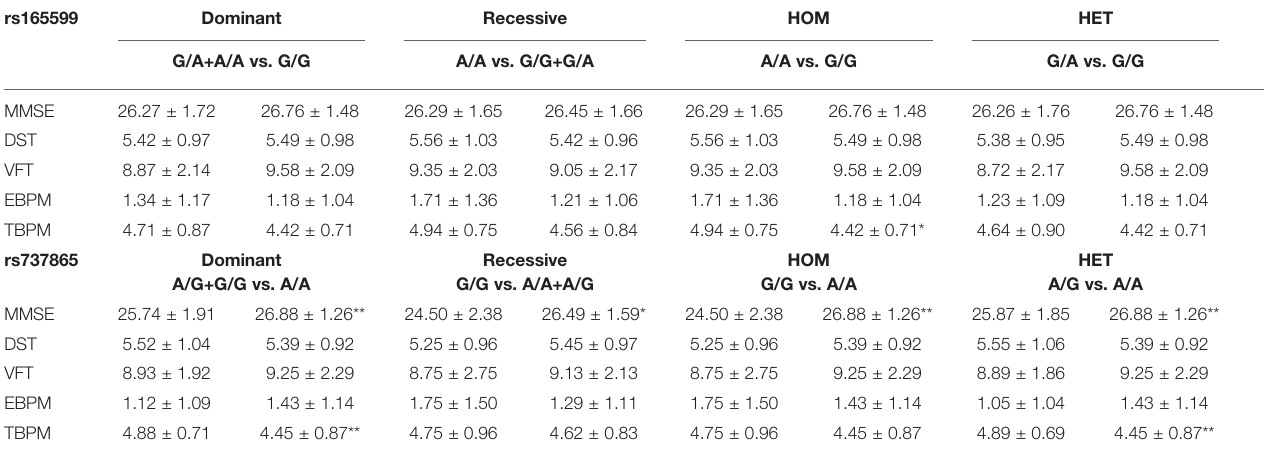
TABLE 6 | Comparison for neuropsychological performance of COMT (rs165599 and rs737865) genotypes and genetic model. rs165599 Dominant Recessive HOM G/A+A/A vs.